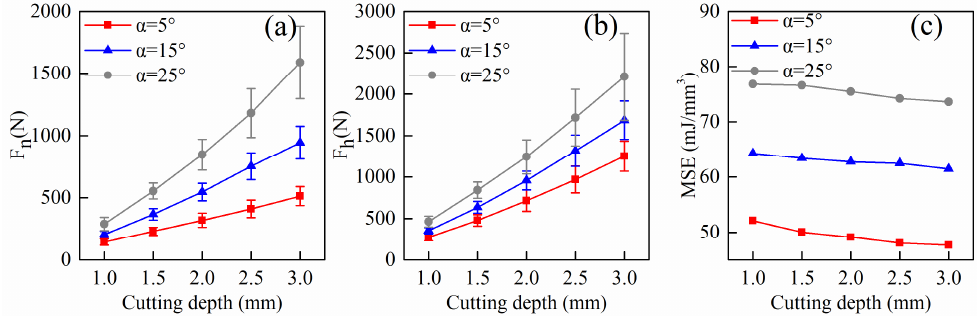
Figure 14. E ff ect of cutting depth on: ( a ) F n ; ( b ) F h ; ( c ) MSE. Figure 14. Effect of cutting depth on: ( a ) F Figure 14. Effect of cutting depth on: ( a ) F n ; ( b ) F h ; ( c ) MSE.